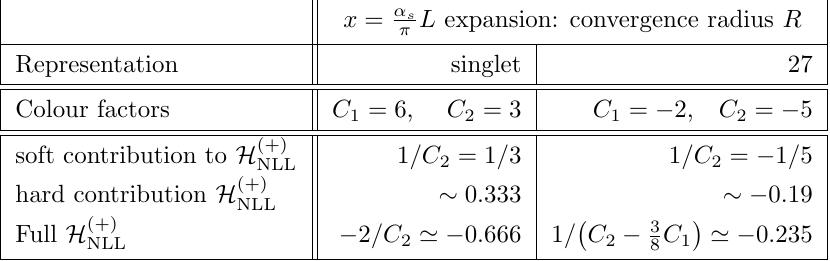
Summary table for the radius of convergence R of the expansion of the